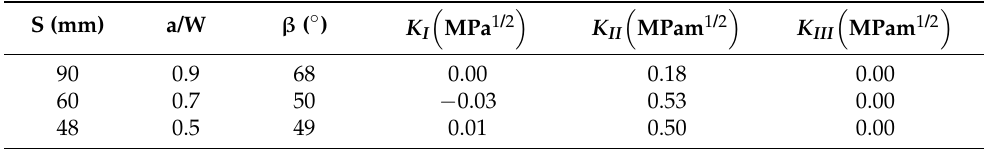
Figure 5. The relationship between dimensionless SIFs Y I , Y II and Y III with respect to horizontal deflection angle α and vertical deflection angle β . ( a ) The relationship between Y I and α . ( b ) The relationship between Y I and β . ( c ) The relationship between Y II and α . ( d ) The relationship between Y II and β . ( e ) The relationship between Y III and α . ( f ) The relationship between Y III and β . Table 5. Pure mode II fracture angle values corresponding to different span S and